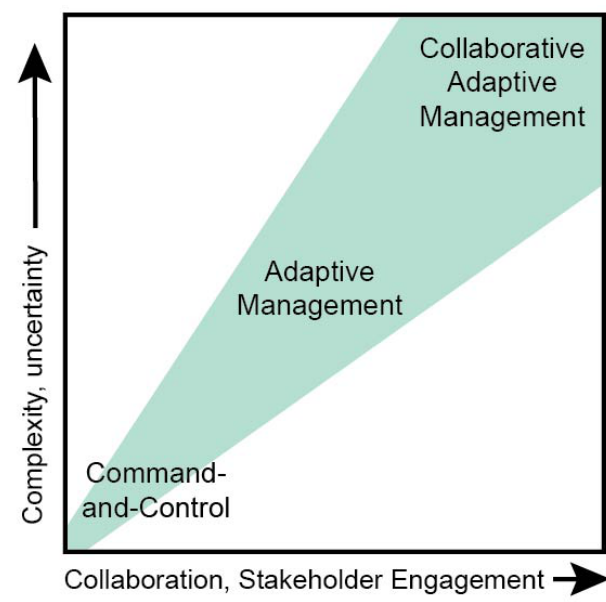
Fig. 1 . Natural resource management approaches fall along a continuum defined by the level of collaboration and stakeholder engagement required to effectively address the complexity and uncertainty of a particular problem